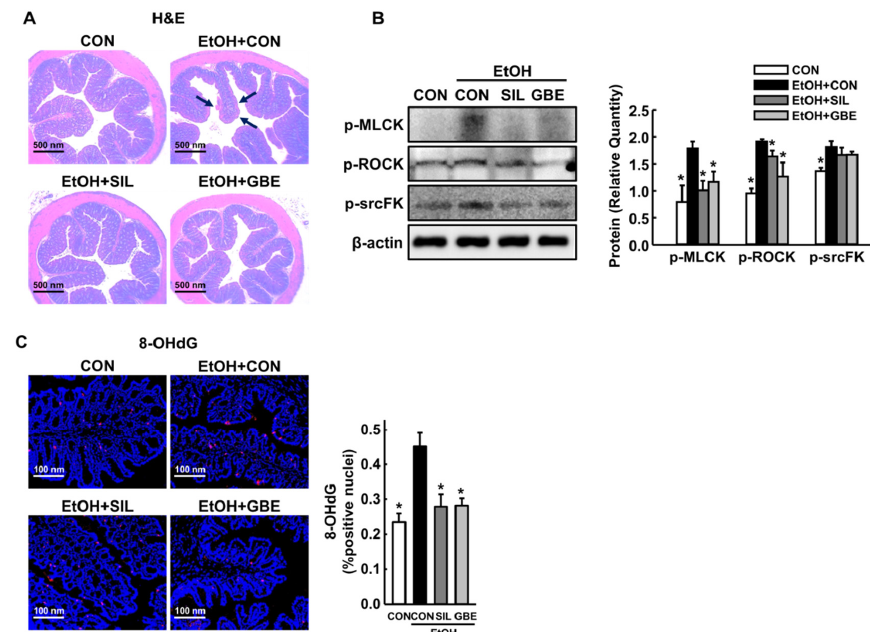
ff ects of GBE against alcohol-induced intestinal hyperpermeability and oxidative Figure 4. Protective effects of GBE against alcohol-induced intestinal hyperpermeability and Figure 4. Protective e